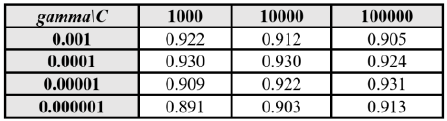
Table 2. Persons 1-10 SVM parameters tuning in cross-validation procedure on frames